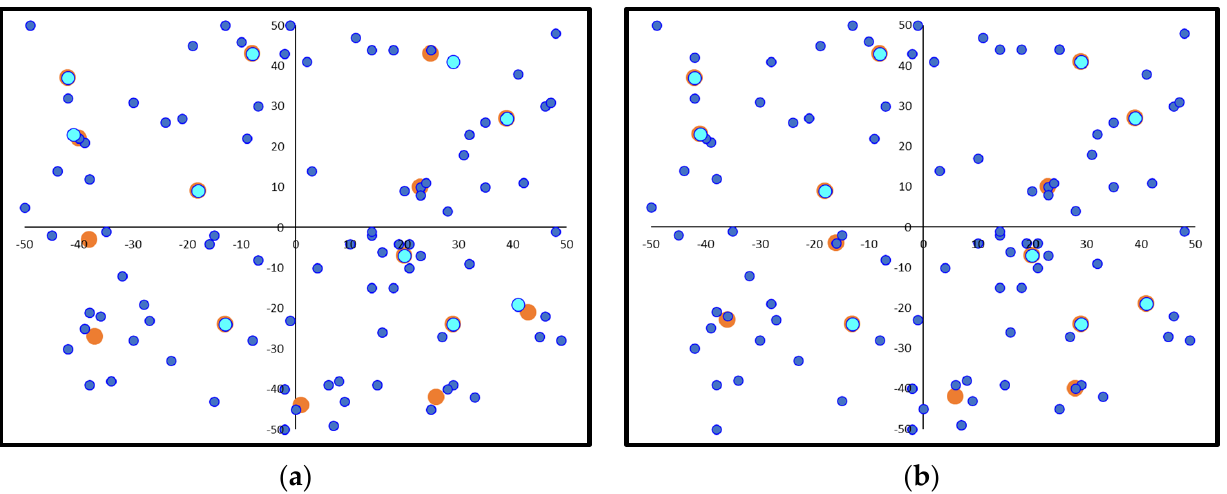
Figure 9. Indicative charging station deployment results for Case Study 5: ( a ) 5 times higher demand in specific points; ( b ) 10 times higher demand in specific points (normal demand points in dark blue color, increased demand points in light blue color, charging stations in orange color).